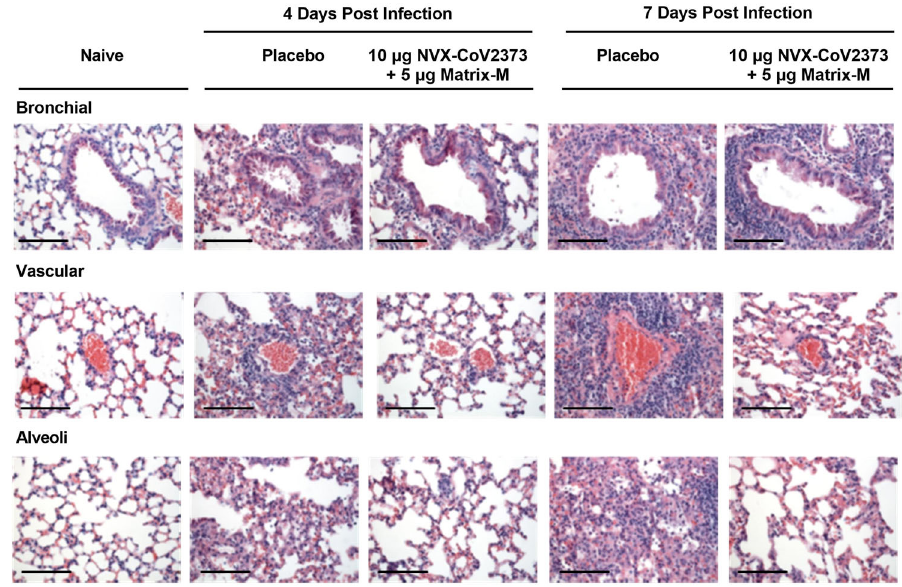
Fig. 5 Histopathological analysis of SARS-CoV-2 infection in NVX-CoV2373-immunized mice transduced with Ad/hACE2 and challenged with SARS- CoV-2. Groups of mice ( N = 10/group) were immunized with NVX-CoV2373 with or without Matrix-M (5 μ g) with two doses spaced 14 days apart. Placebo group received formulation buffer. Following immunization, mice were intranasally transduced with Ad/CMV/hACE2, 52 days after the fi rst priming dose. At 4 days post transduction, mice were challenged with 1 × 10 5 pfu/mouse of SARS-CoV-2 (WA1 strain). Lungs were collected 4 and 7 days post infection. Representative placebo control animal at 4 days post infection showing denuding of bronchial epithelium with marked thickening of the alveolar septa surrounded by mixed in fl ammatory cells. Diffuse perivascular cuf fi ng was observed throughout the lung, consisting of neutrophils and macrophages. At 7 days post infection, peribronchiolar in fl ammation and perivascular cuf fi ng was markedly increased. Lungs from NVX-CoV2373- vaccinated animals had little or no epithelial cell sloughing or infection within large and small bronchi at days 4 and 7 post infection. There was no evidence of exacerbated lung in fl ammation in NVX-CoV2373-immunized animals. Images from age- and sex-matched BALB/c mice from a separate experiment that were transduced with Ad/hACE2 alone as a control are shown in the right panel at 7 days post transduction. Scale bar 100 μ